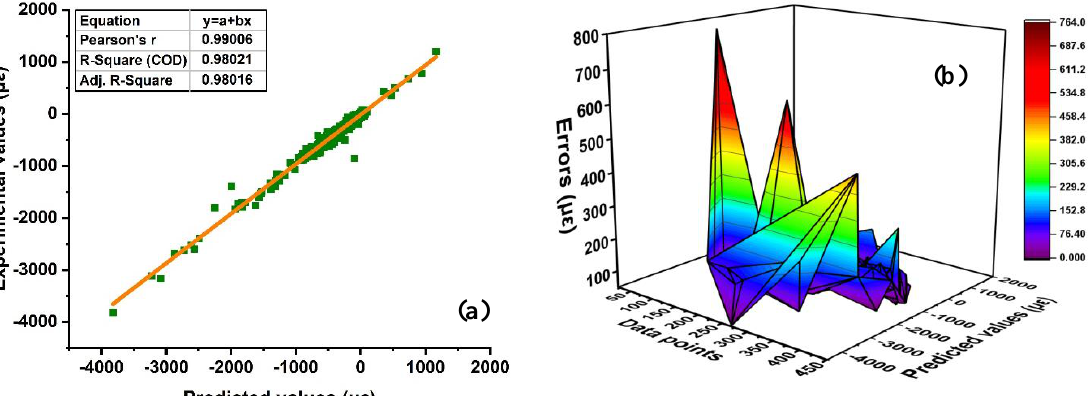
12 of 23 Figure 6. SVM ensemble model; ( a ) SVM with bagging; ( b ) Error distribution of SVM bagging. 4.2. Random Forest Regression